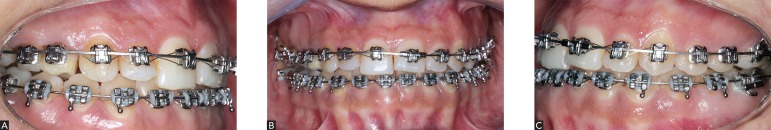
Intraoral photographs at the end of leveling in the maxillary arch (with 0.019 x
0.025-in wire) and in the mandibular arch (with 0.018" steel wire